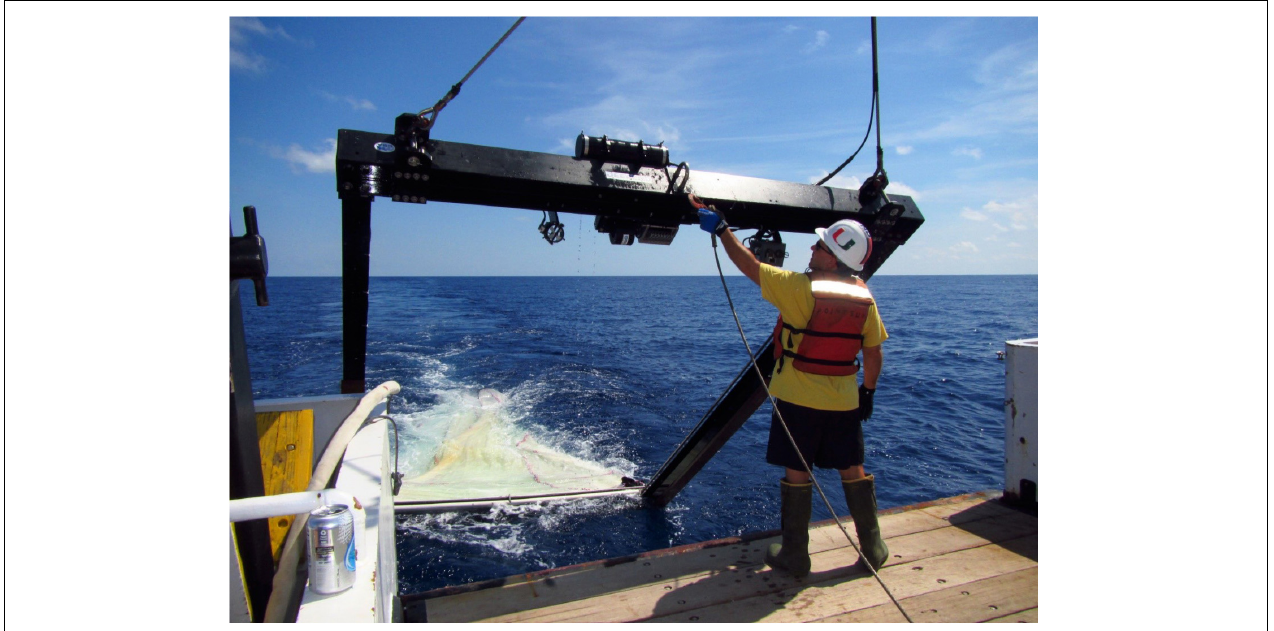
FIGURE 4 | MOC10 unit used to quantitatively sample discrete-depth strata during ONSAP and DEEPEND cruises. Image courtesy of DEEPEND/Danté Fenolio. Written informed consent was obtained from the individual for the publication of any potentially identifiable images included in this article.